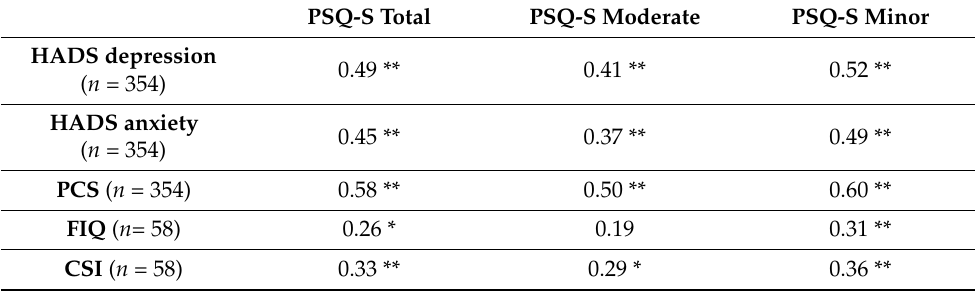
Table 3. Convergent validity measured by Pearson correlation.